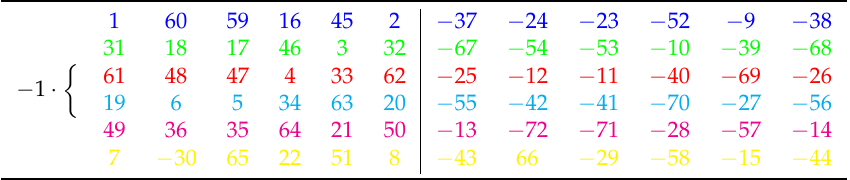
Table 26. WDT of a 6-phase reduced winding with N = 96, p = 5, q = 1 + 2 / 10 , and double sided imbrication of the 1-st